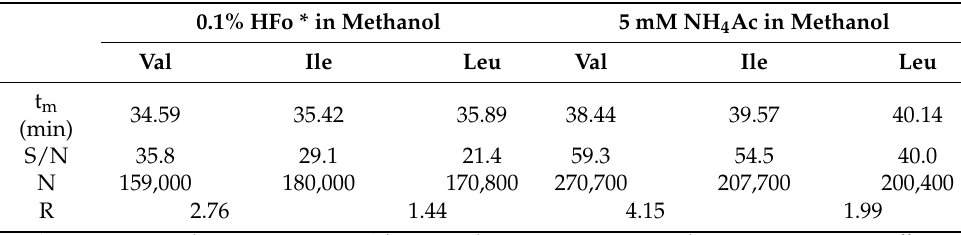
Table 3. Effect of the sheath liquid composition on BCAA separation.